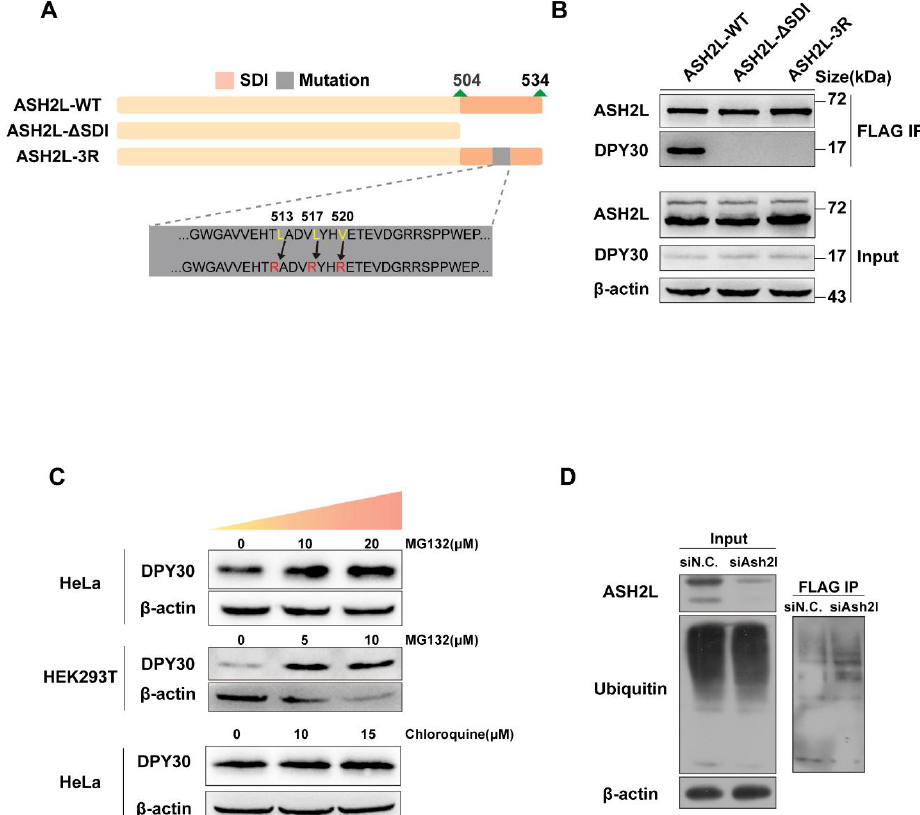
Figure 4. The stability and degradation of DPY30 ( A ) Construction of the ASH2L-WT, ASH2L- ΔSDI , and ASH2L-3R mutations. ( B ) Coimmunoprecipitation assay using FALG-tagged ASH2L-WT, ASH2L-SDI, and ASH2L-3R to detect their binding with DPY30. ( C ) Gradient doses of MG132 (upper panel) and chloroquine (lower panel) were used to inhibit the cell proteasome and lysosome, respectively, and the relative expression level of DPY30 in different cell lines was observed by Western blot. Experiments in different cell lines were repeated three times. ( D ) Coimmunoprecipitation assay using FLAG-tagged DPY30 to detect the binding of ubiquitin after knockdown of